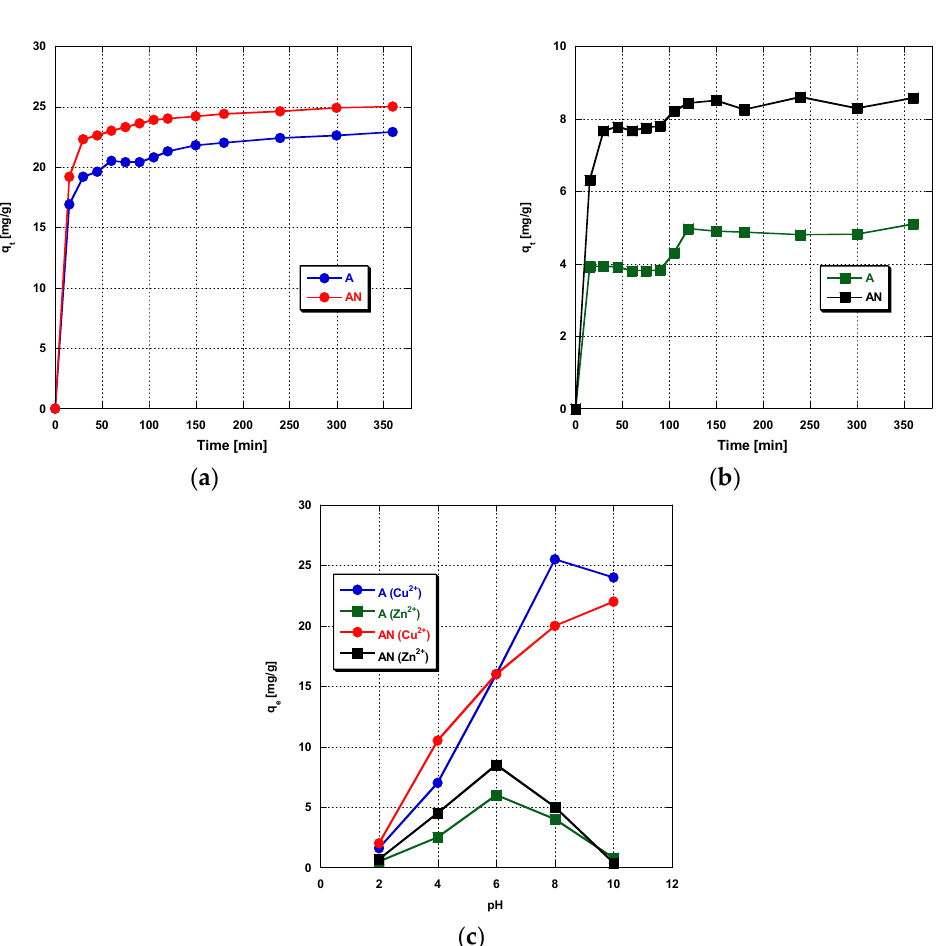
Figure 1. The effect of the phase contact time on the heavy metals ions’ adsorption on activated carbons ( a ) Cu(II) ions’ adsorption, ( b ) Zn(II) ions’ adsorption, and ( c ) simultaneous adsorption of Zn(II) and Cu(II); C init 10 mg/L, pH 6, mass of sorbent: 0.01 g, time 360 min, shaking speed 180 rpm, temperature 22 ± 2 °C.